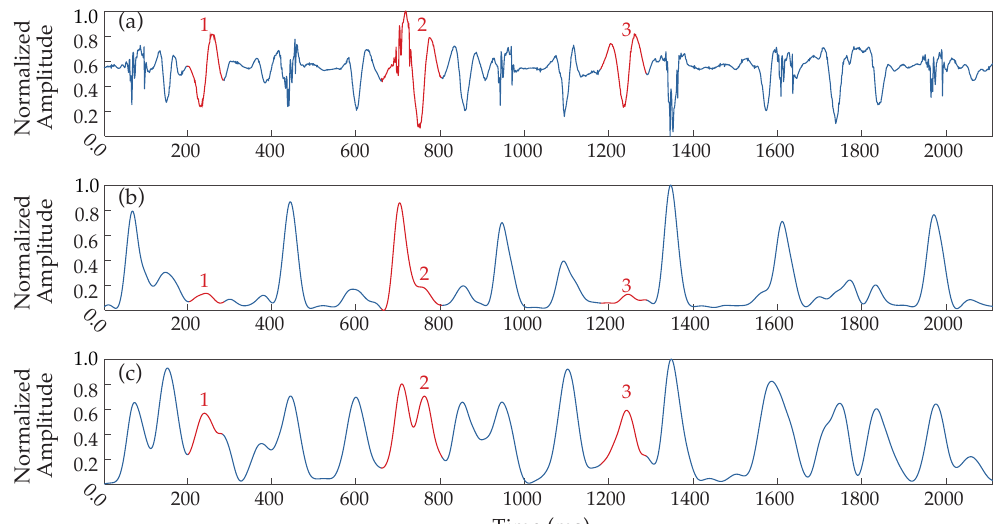
Figure 3. Alternative Botteron’s filtering. ( a ) Denoised EGM and resulting signals from ( b ) original Botteron’s filtering (40–250 Hz band-pass filter) and ( c ) the band-pass filter’s cut-offs modification to 20–250 Hz implemented by the proposed method. Numbers 1–3 (red) indicate three clear examples of improved responses to